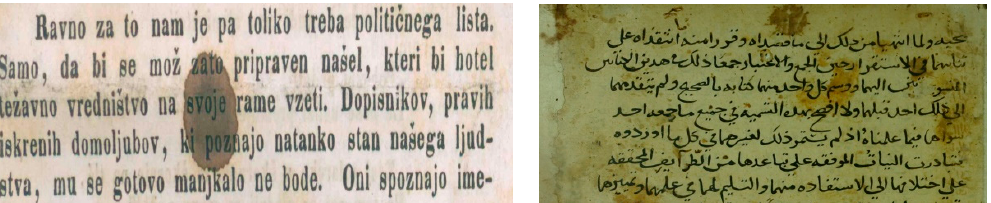
Figure 7. Example showing degraded document with smear/show-through effects.